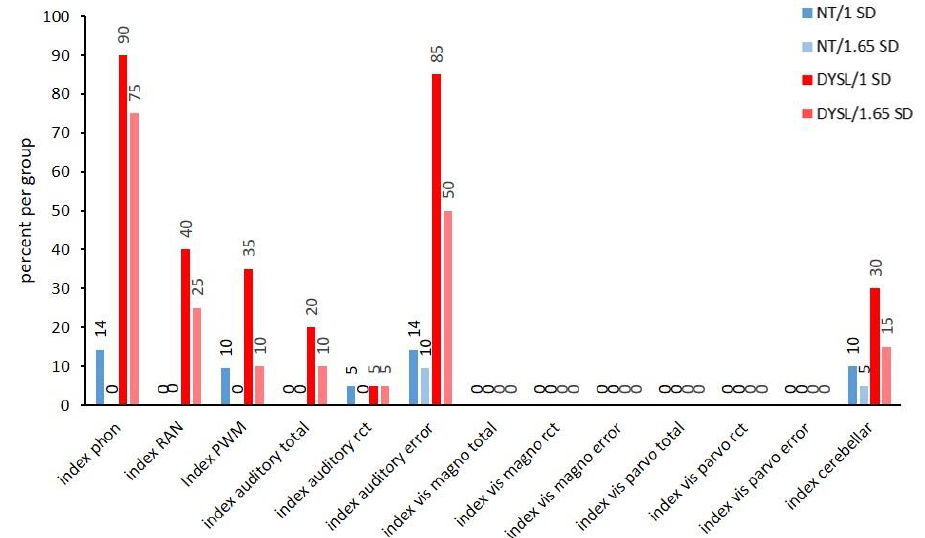
Figure 1. Deviant performance in percent per group at the index level. NT: neurotypical readers, DYSL: dyslexic readers, number above bars: percentage of individuals with deviating performance in the respective index, phon: phonological awareness, RAN: rapid automatized naming, PWM: phonological working memory, rct: reaction time, magno: magnocellular, parvo: parvocellular.